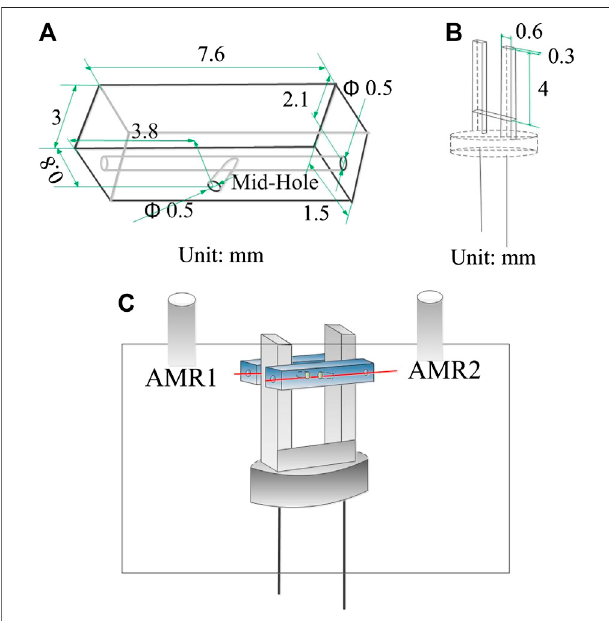
FIGURE 1 | QEPAS spectrophone structure based on two off-beam AMRs. (A) Off-beam AMR structure parameters. (B) QTF dimensional parameters. (C) Complete QEPAS spectrophone